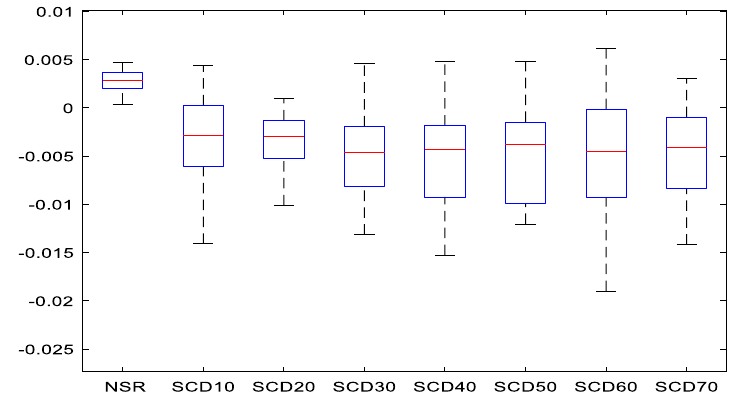
Fig. 5 Boxplot analysis of S